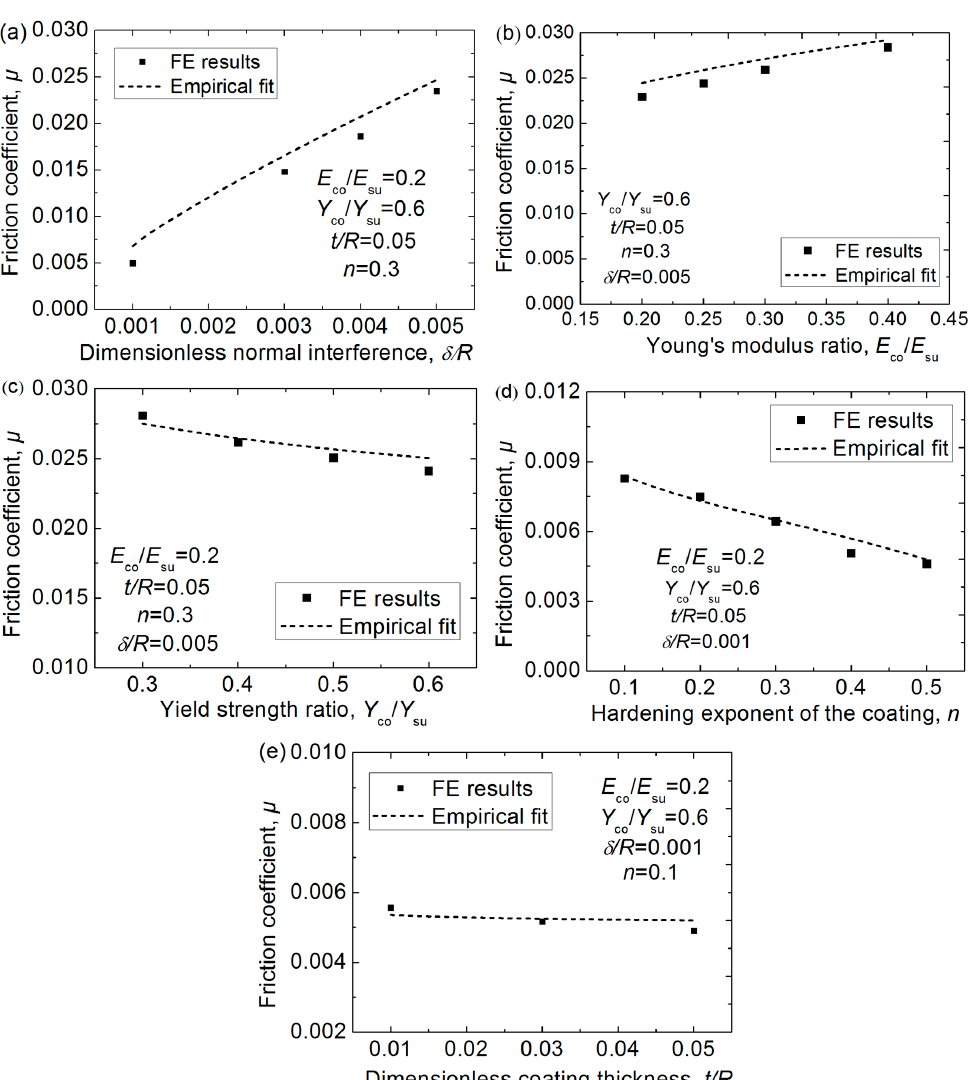
Figure 7. The effective friction coefficient due to the plastic deformation μ in the asperity sliding Figure 7. The e ff ective friction coe ffi cient due to the plastic deformation µ in the asperity sliding process under di ff erent normal interferences, δ / R , for di ff erent cases where Young’s modulus ratios, E co / E su , yield strength ratios, Y co / Y su , hardening exponent, n , and thickness, t / R , of the coating changes in a di ff erent specific range. ( a ) The e ff ect of δ / R on µ ; ( b ) The e ff ect of E co / E su on µ ; ( c ) The e ff ect of Y co / Y su on µ ; ( d ) The e ff ect of n on µ ; ( e ) The e ff ect of t / R on µ